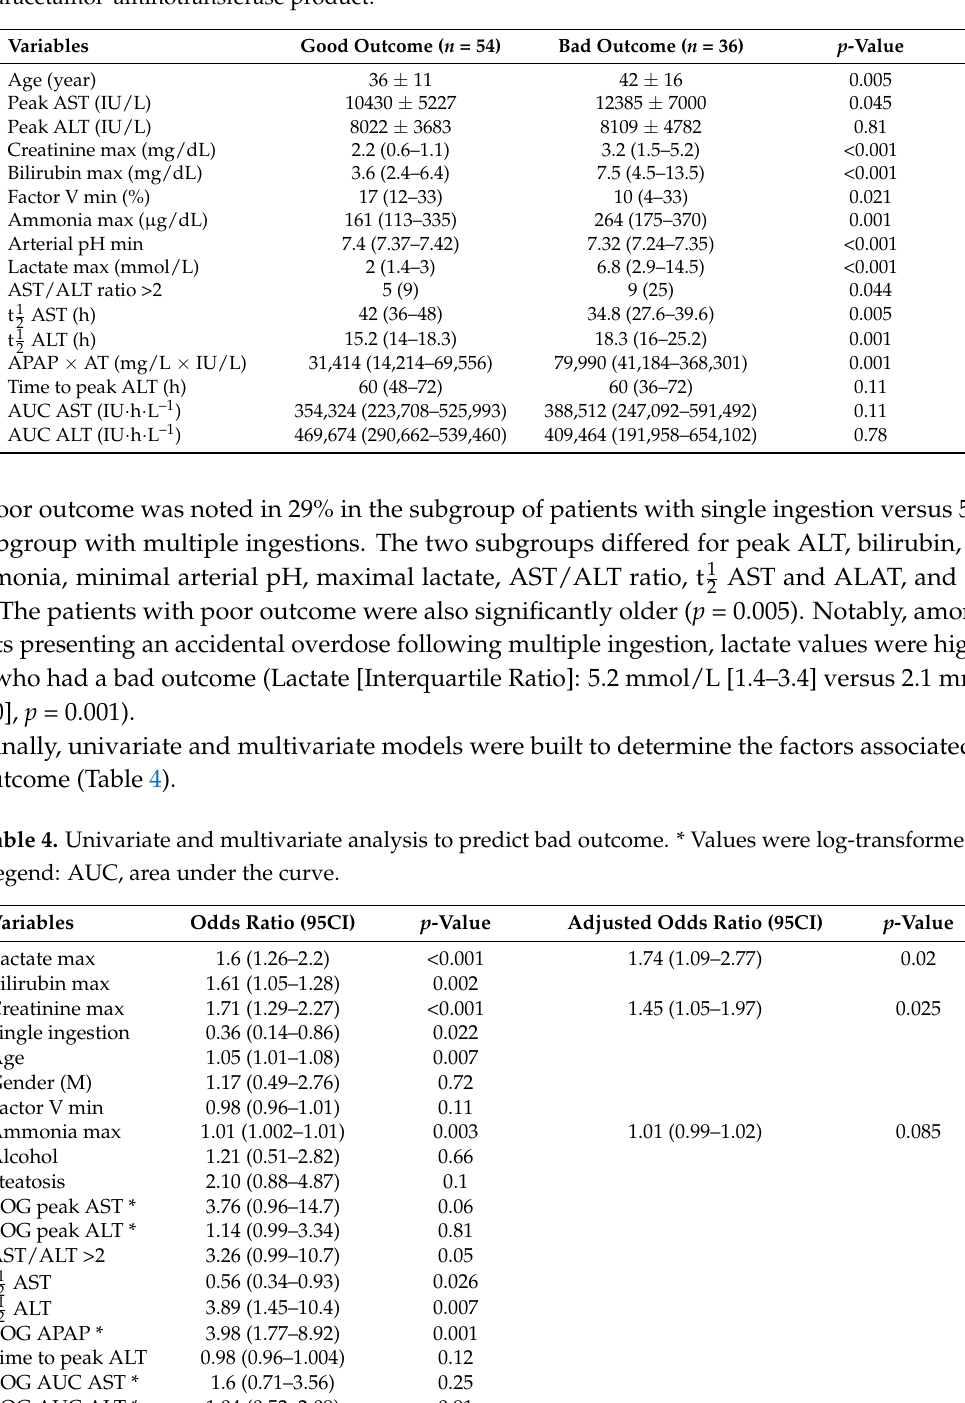
Table 3. Analysis of variables in the subgroups with good or bad outcome. Legend: APAP × AT, paracetamol–aminotransferase product.